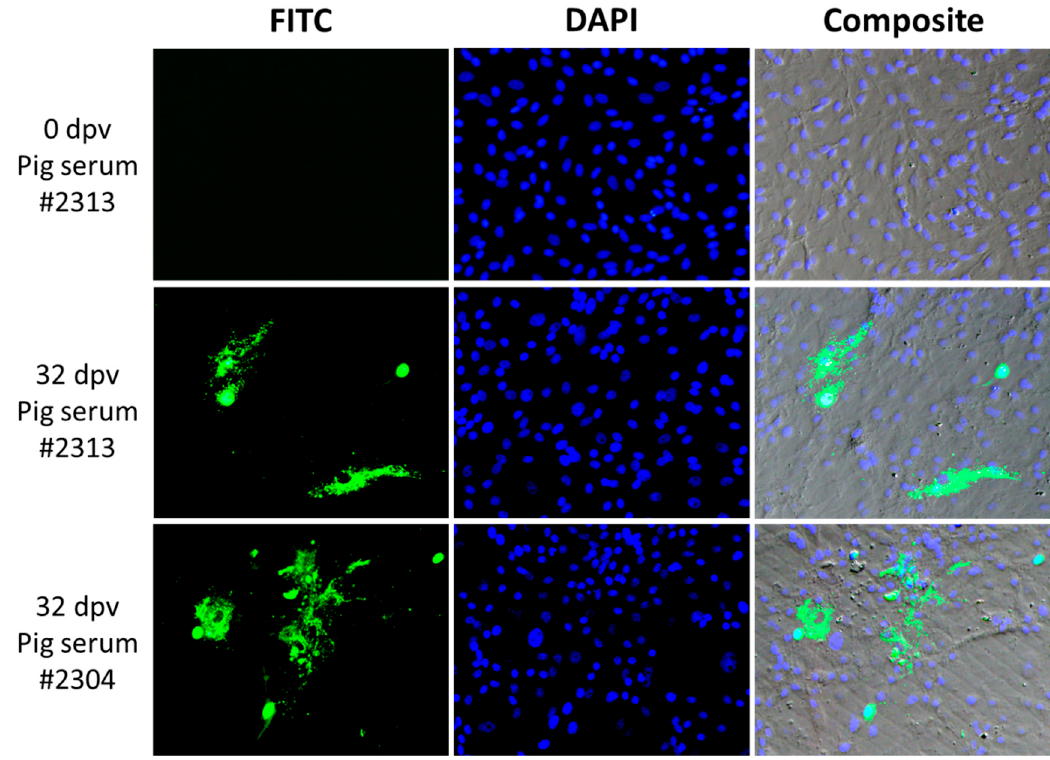
Figure 12. Indirect immunofluorescence assay (IIFA) for serum samples collected from PRVtmv+ immunized pigs. Swine kidney cells were transfected with PCV2b plasmid. At 72 h post-transfection, cells were fixed and IIFA were performed using serum samples collected from PRVtmv+ immunized pig on 0 day post-vaccination (dpv) (pig #2313) and 32 dpv (pig #2313 and 2304) as a primary antibody and fluorescent ‐ labeled anti ‐ porcine secondary antibody with DAPI nuclear stain. Positive signals were indicated by bright apple ‐ green fluorescent signals. (Magnifications 200×).